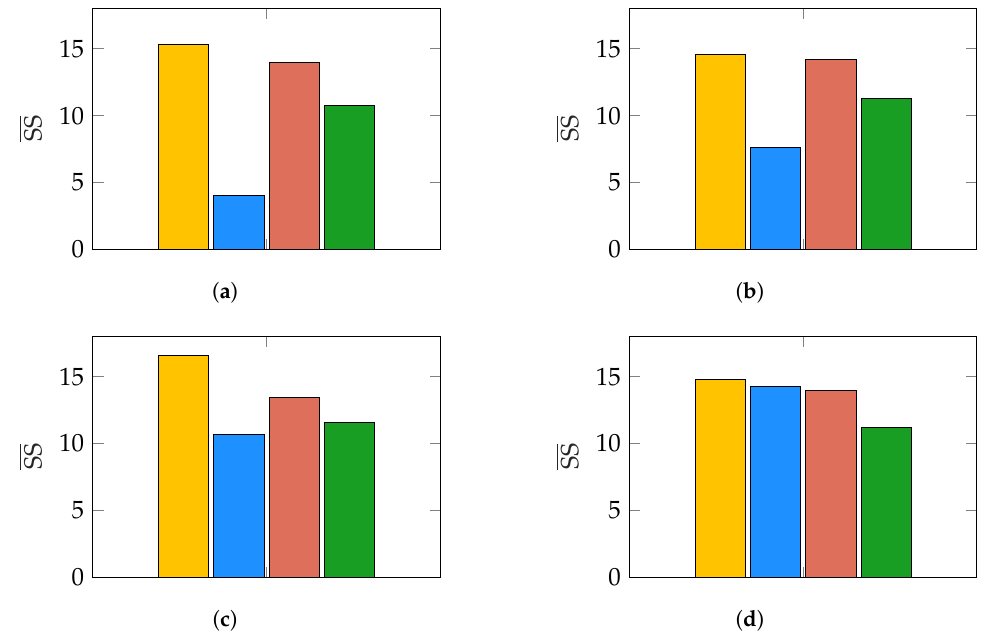
Figure 6. Results of evaluating SS for different noise conditions. Bars correspond to P ( W 0 ) (yellow), ι (blue), ι (red), and ι (green). ( a ) Noise conditions: η b = 10 dB, η m = 10 dB; ( b ) noise MAI RR1 RR2 conditions: η b = 5 dB, η m = 5 dB; ( c ) noise conditions: η b = 0 dB, η m = 0 dB; ( d ) noise conditions: η b = − 5 dB, η m = 0